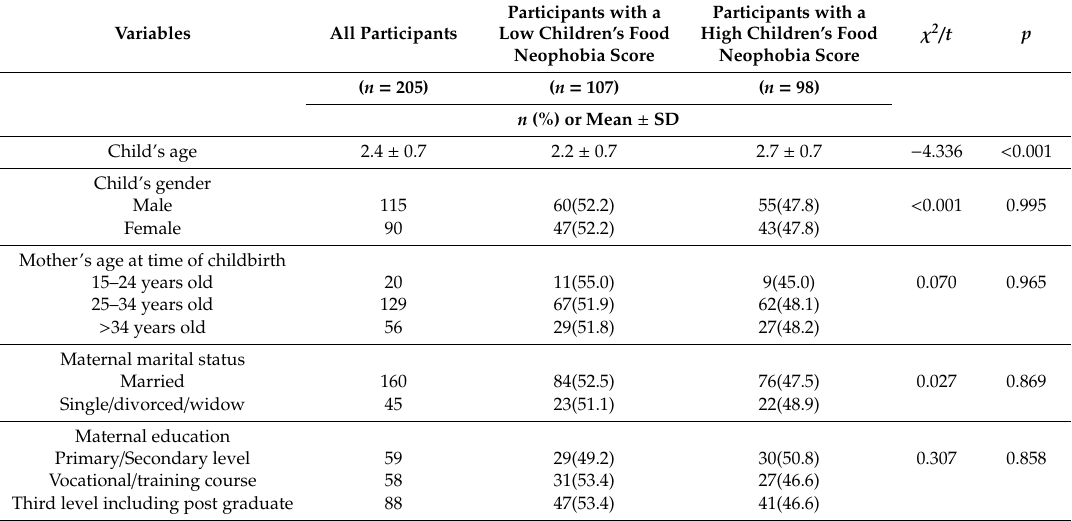
Table 2. Characteristics and infant feeding practices of participants classified by participants with low and high children’s food neophobia